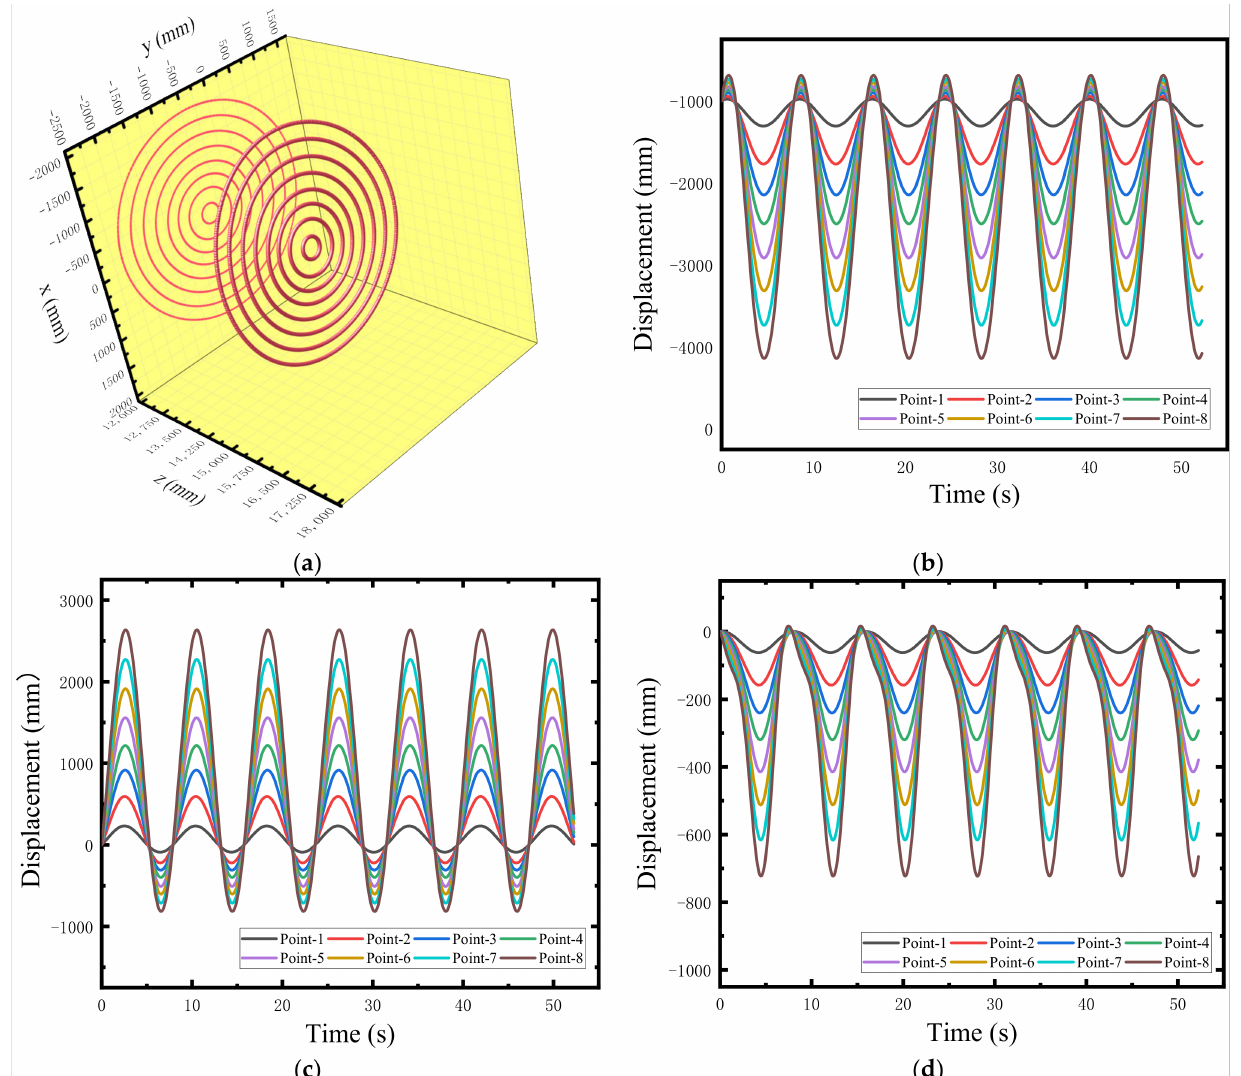
Figure 15. 3D motion of the blade: ( a ) 3D trajectory; ( b ) displacement in x direction; ( c ) displacement in y direction; ( d ) displacement in z